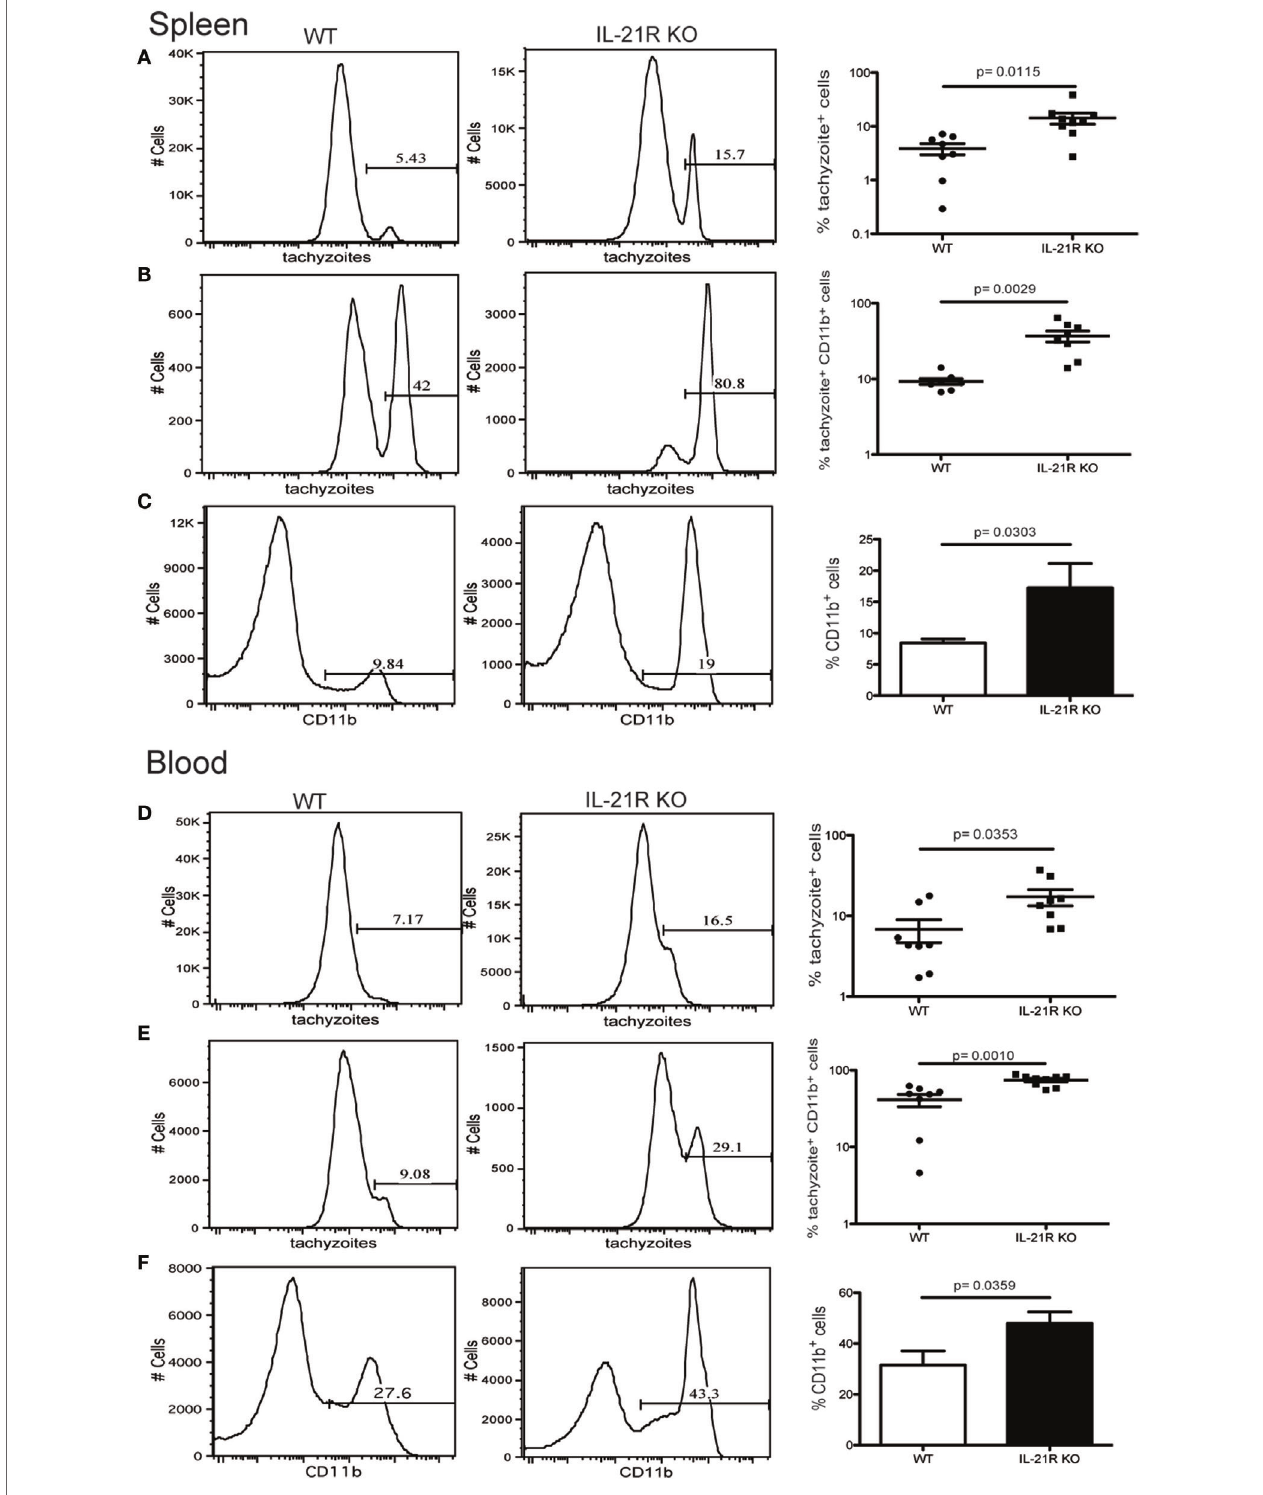
FigUre 5 | Increase in number of Toxoplasma gondii -infected cells after loss of IL-21 signaling. Analysis of T. gondii -infected cells in the spleen (a–c) and blood (D–F) from WT and IL-21R KO-infected animals at week 7 p.i. Plots are gated on total lymphocytes (a,D) . Graphs represent the percentage of infected CD11b + (B,e) . Percentage of CD11b + cells from infected WT and IL-21R KO mice (c,F) . Experiments were carried out at least twice and data are representative of one